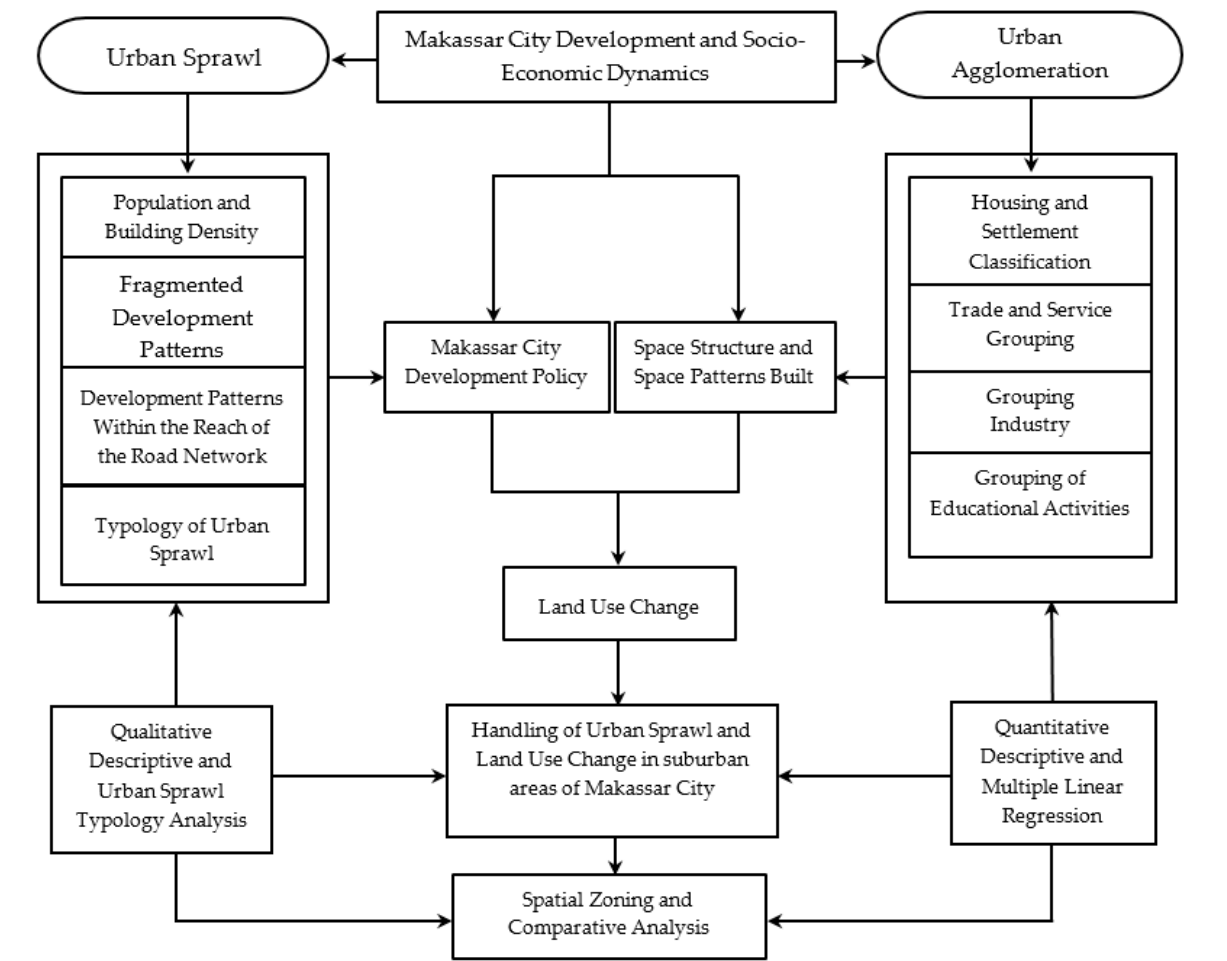
Figure 3. Flowchart of the methodology. Source: Author elaborator.